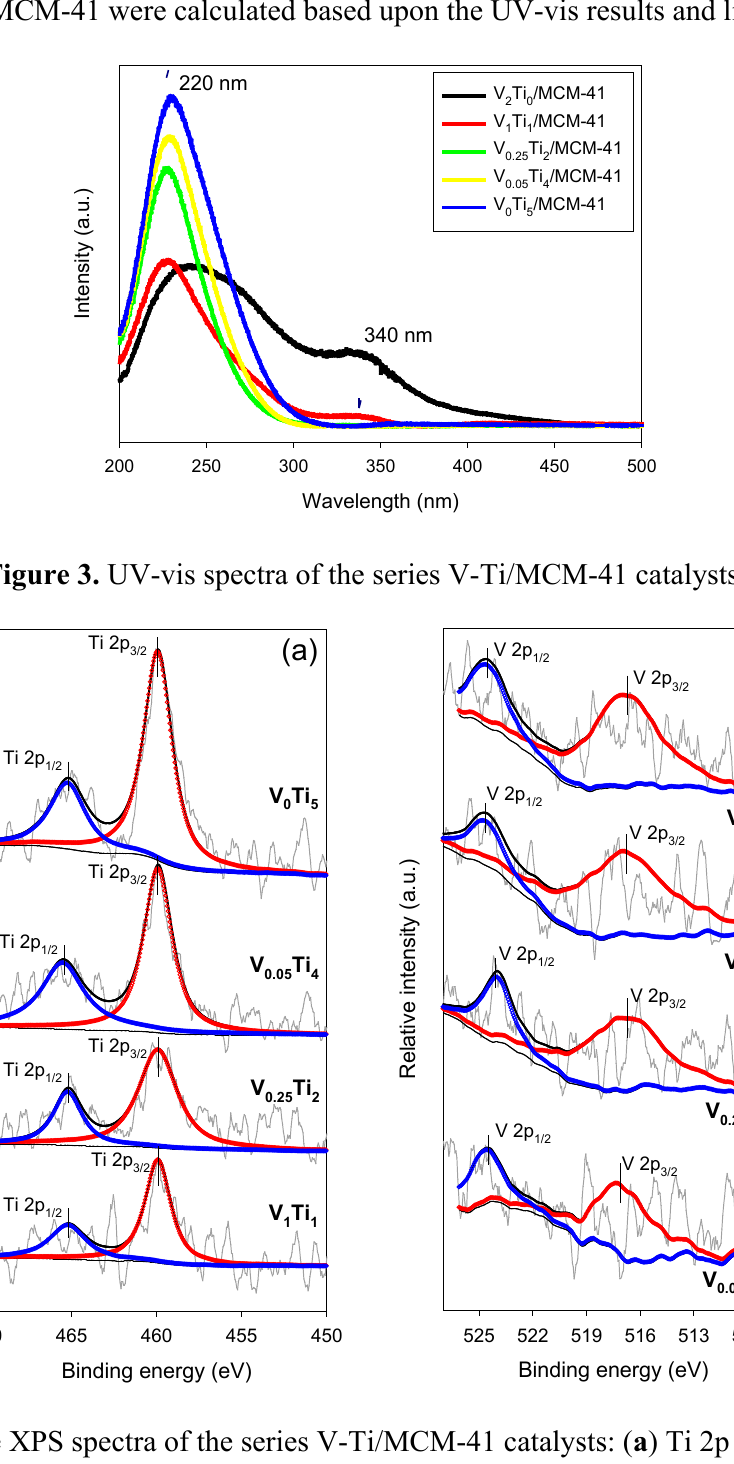
Figure 4. The XPS spectra of the series V-Ti/MCM-41 catalysts: ( a ) Ti 2p and ( b ) V